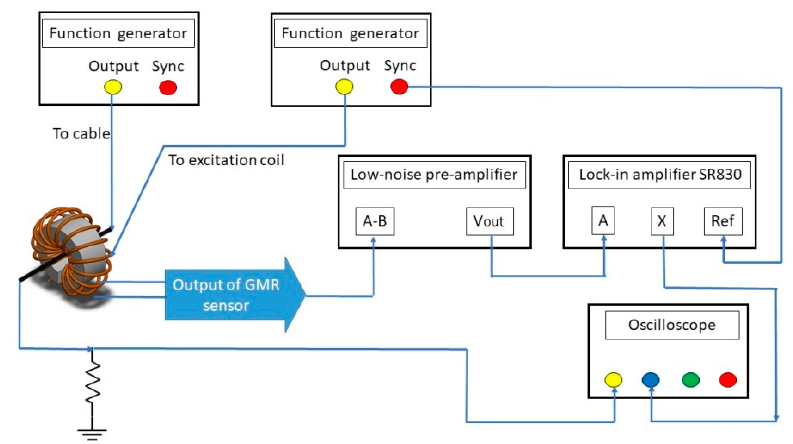
Figure 5. Experimental installation schematic of the GMR-based current measurement system.